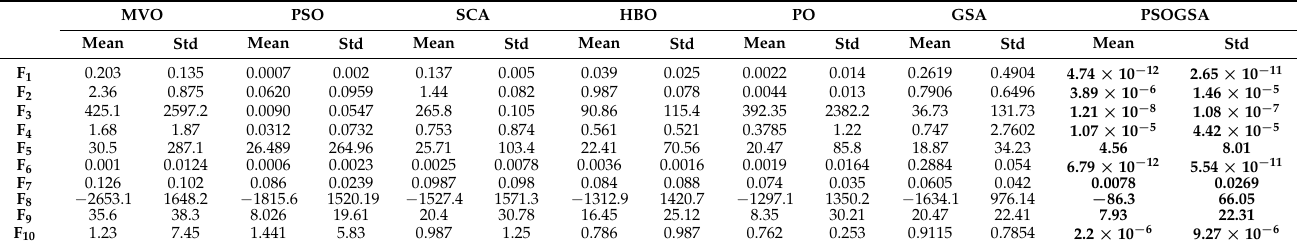
Table 2. Results of benchmark test functions for different optimization